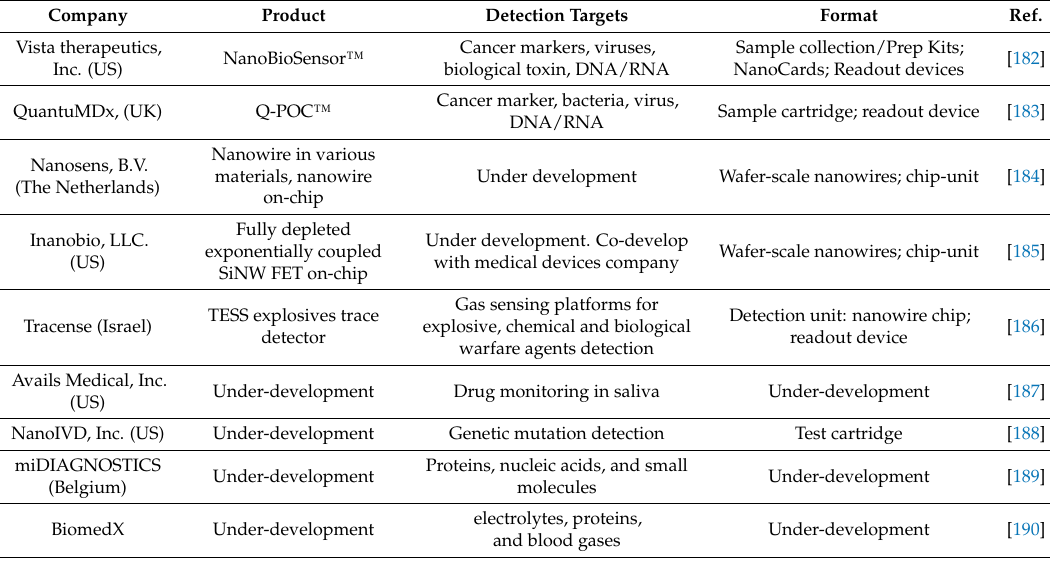
Table 3. Early commercial SiNW FET platforms and targeted